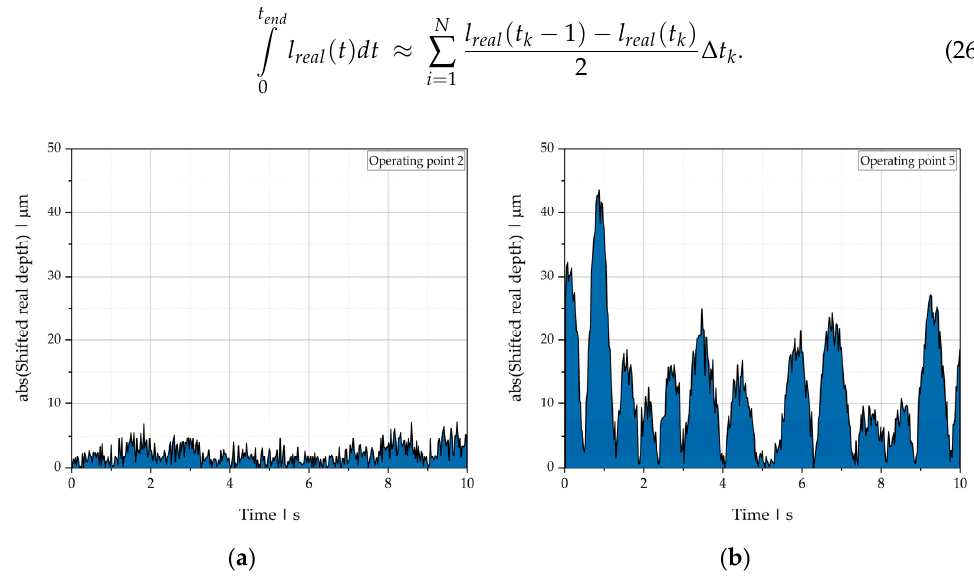
Figure 12. Signal intensities for absolute values of real length position of the polymer-polymer in-